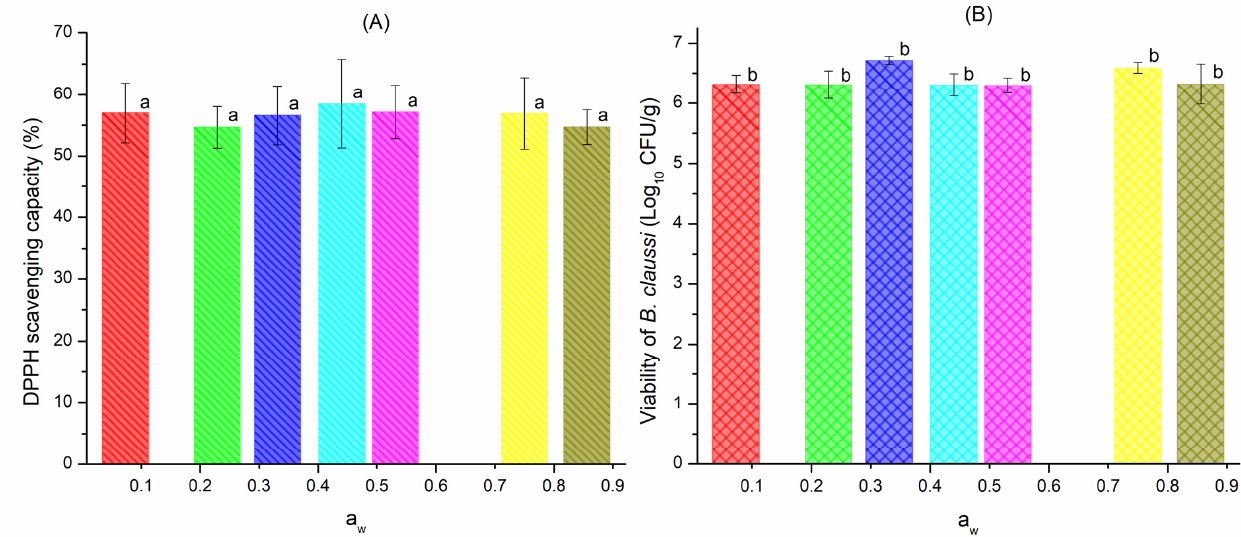
Figure 6. Functional performance of the blend MX-IN:25-75: ( A ) antioxidant activity of quercetin and ( B ) viability of B. claussi microorganisms. The lowercase letters indicate differences in the means at a significance value of 0.05.